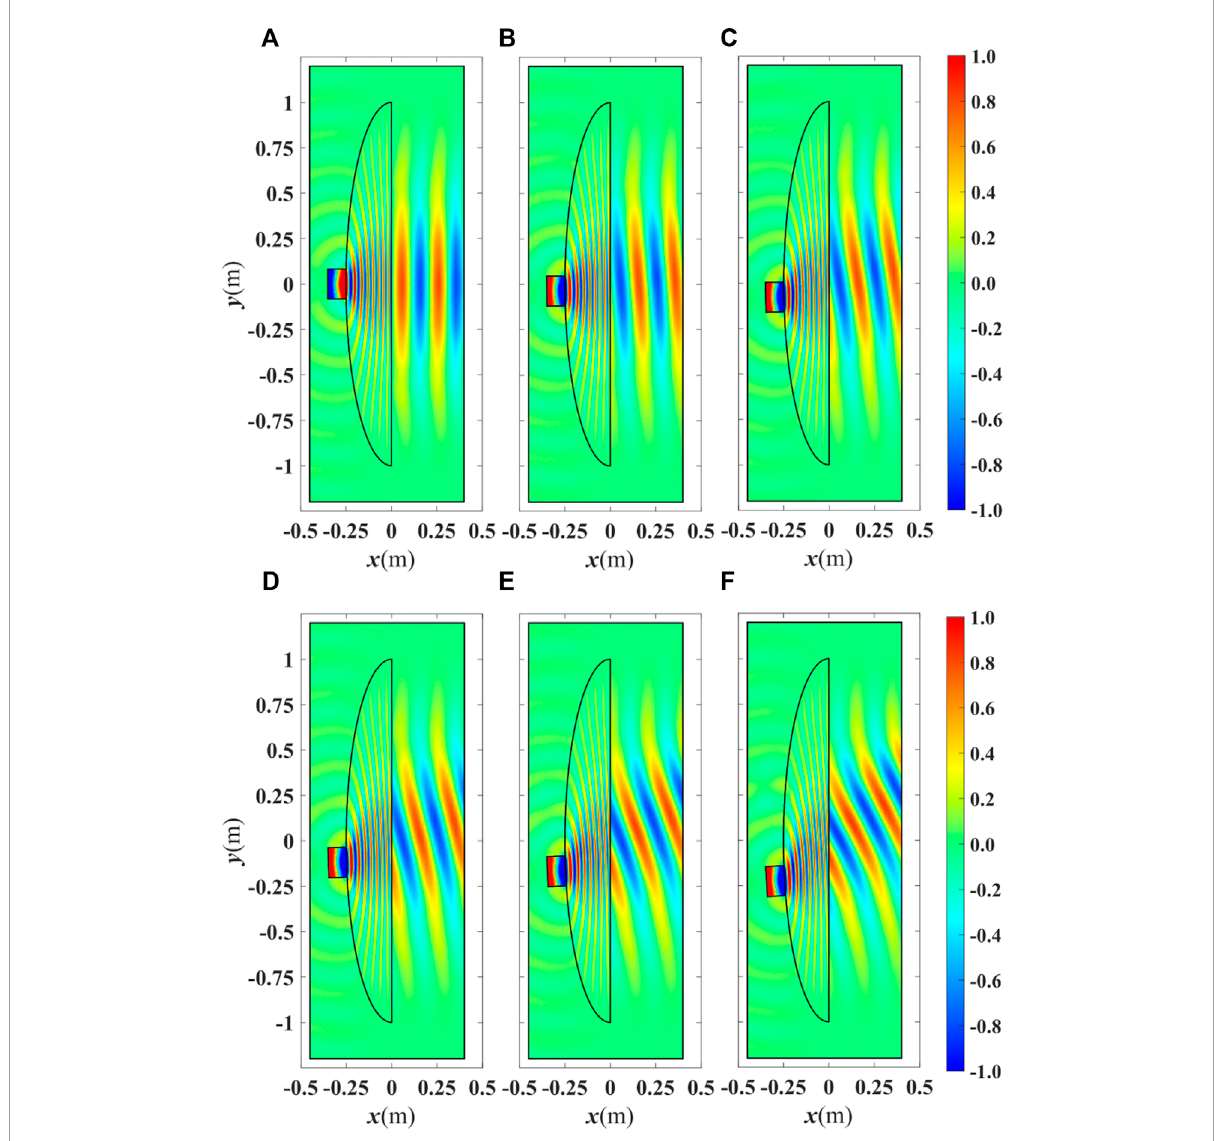
FIGURE 4 Real part of H z for the EHMFEL excited by a waveguide carrying the TM 0 mode at a frequency of 1.5 GHz for a beam direction θ of (A) 0°, (B) +4°, (C) +8°, (D) +12°, (E) +16°, and (F) +20°. The waveguide is moved across the elliptical boundary to achieve beam